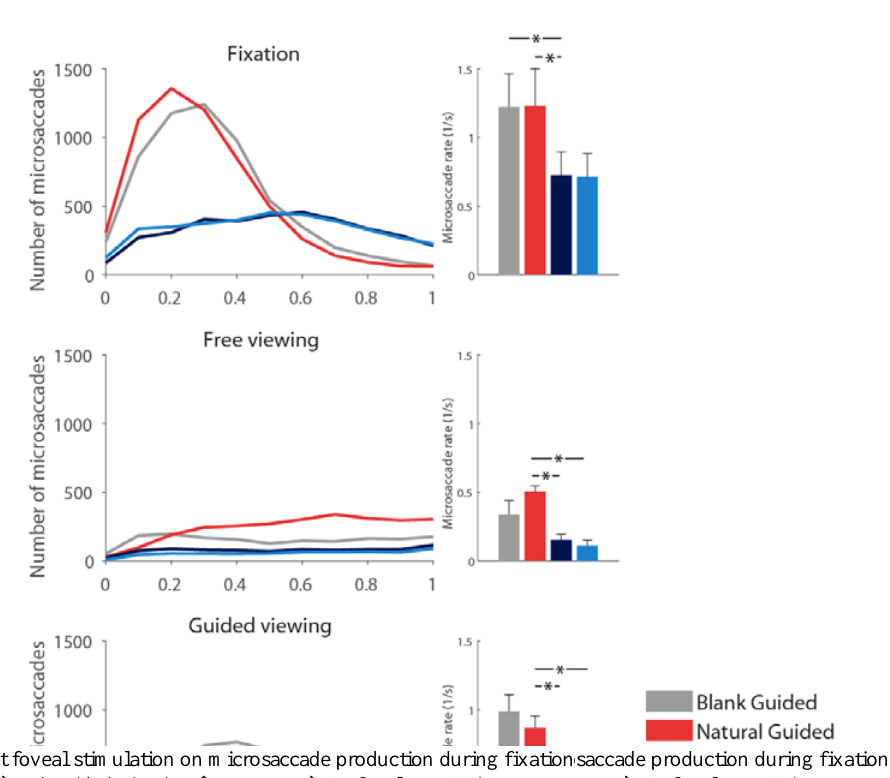
Figure 5. Effect of present vs. absent foveal stimulation on microsaccade production during fixation (top row), free viewing (middle row) and guided viewing (bottom row). Left column: Microsac- cade amplitude distributions for each experimental condition, for all subjects combined. Right col- umn: Average microsaccade rate across subjects. Overall, the solid scotoma and blurred scotoma conditions resulted in lower microsaccade rates than the natural scene and blank scene conditions. Error bars indicate the standard error of the mean (N=6 subjects). Significant comparisons are high- lighted with an asterisk (p<0.05).